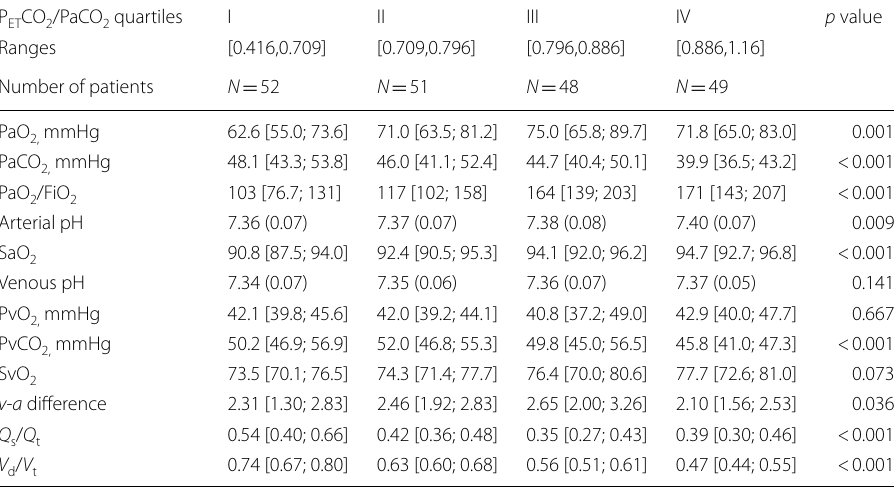
CO /PaCO ratio quartiles ET 2 2